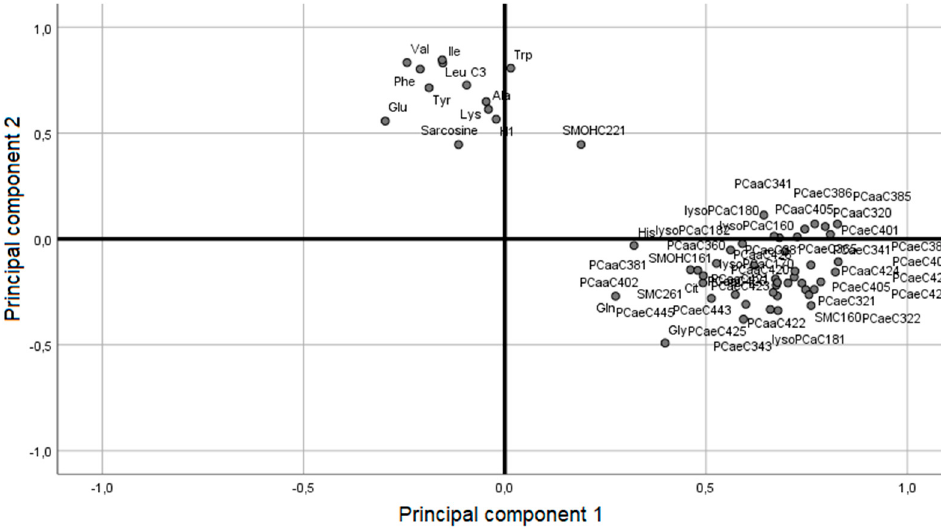
Figure 1. Unsupervised principal component analysis of 57 significantly different metabolites be- tween lifestyle intervention and surgery group in the WAS cohort at 1-year follow-up. The first component explains 32% of the variation, and the second component 17%. C, acylcarnitine; lysoPC, lysophosphatidylcholine; PC aa, phosphatidylcholine with ester bonding; PC ae phosphatidylcholine with ether bonding; SM, sphingolipid.